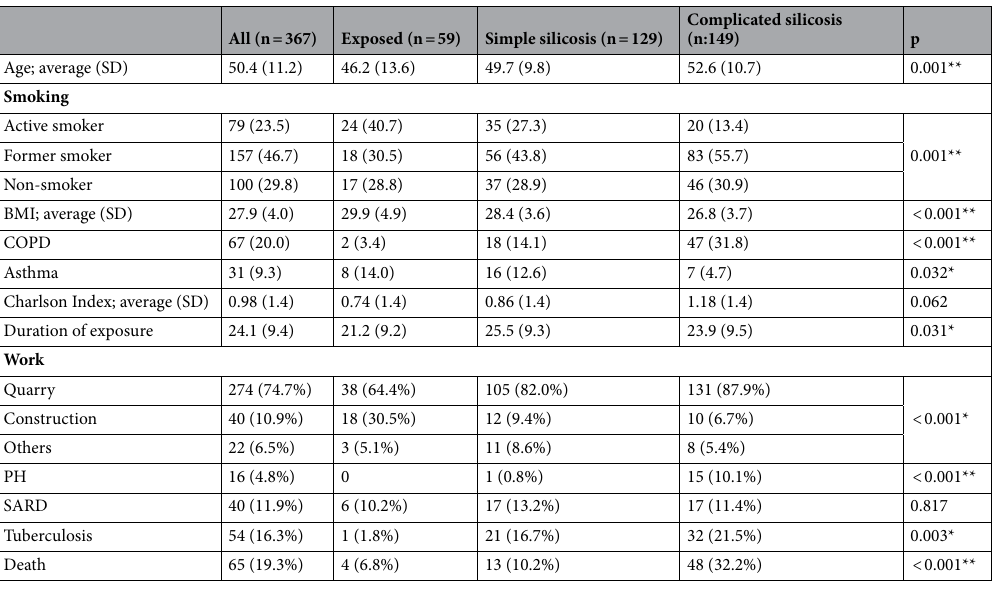
Table 1. General characteristics of the patients included in the study. BMI body mass index, PH pulmonary hypertension, SARD systemic autoimmune rheumatic disese, COPD chronic obstructive pulmonary disease. Statistical significance was determined using χ 2 test and ANOVA test for qualitative and continuous variables, respectively. *p < 0.05; **p <